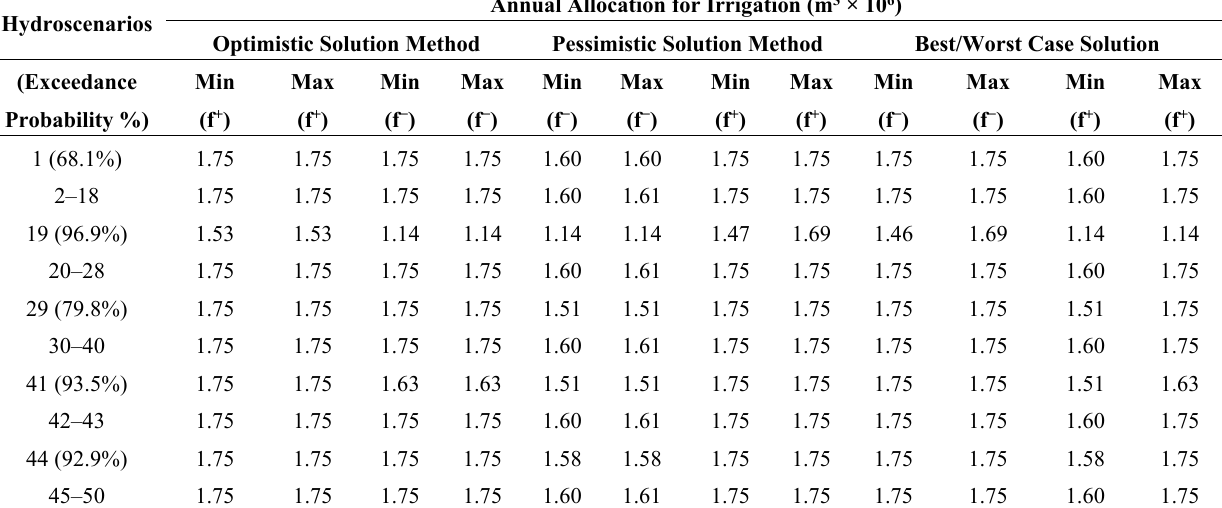
Table 14. Annual Allocation for irrigation (m 3 × 10 6